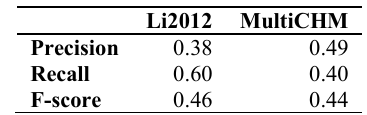
Table 1. Tree detection rates and overall F-score.